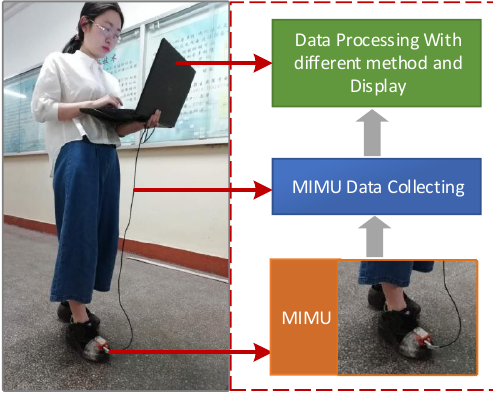
Figure 9. Pedestrian-positioning test structure.